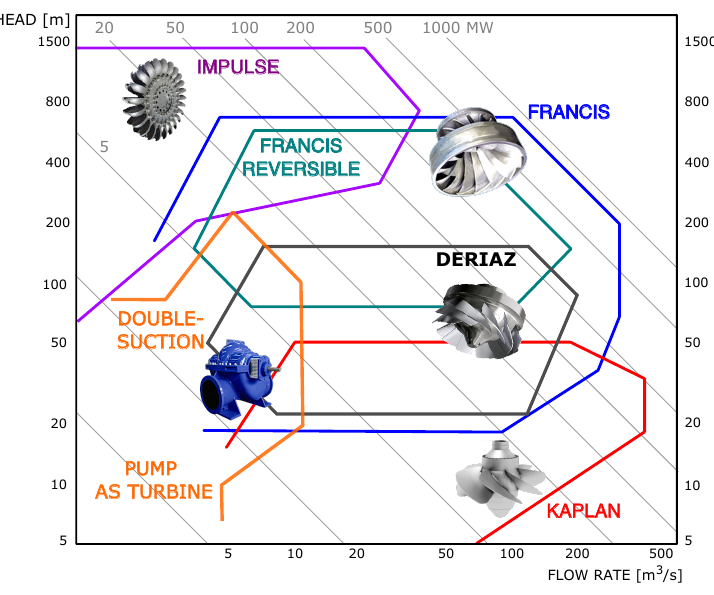
Figure 1. Types of hydraulic turbines in their application area Q-H. Adapted from [38,46,47] and authors’